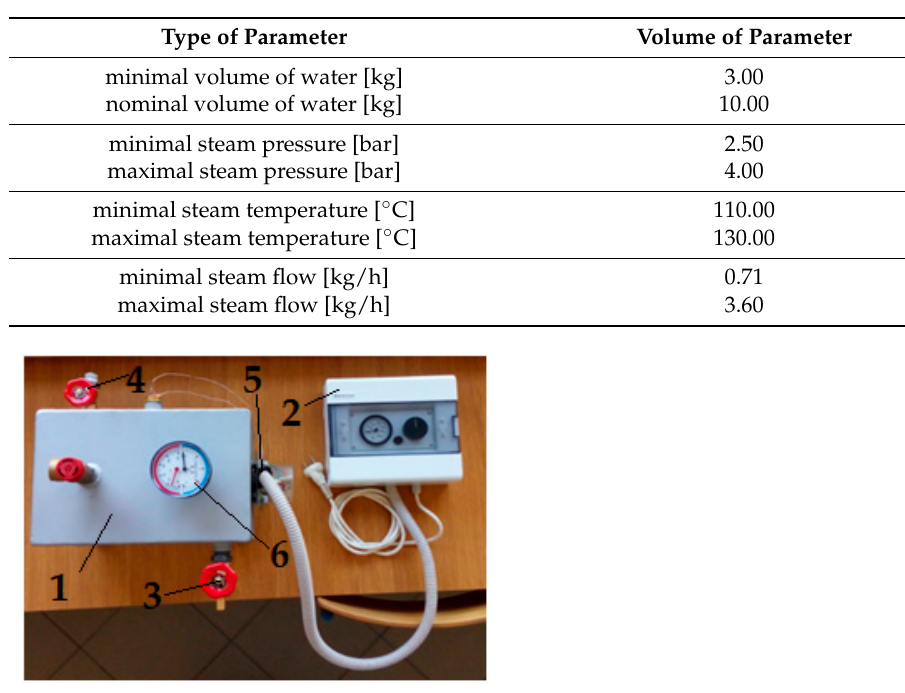
Table 2. Technical parameters of the designed steam generator.